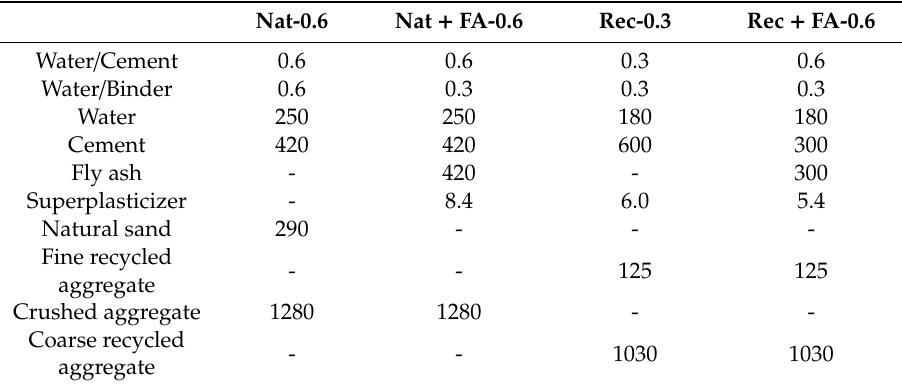
Table 3. Concrete mixture proportions (kg / m 3